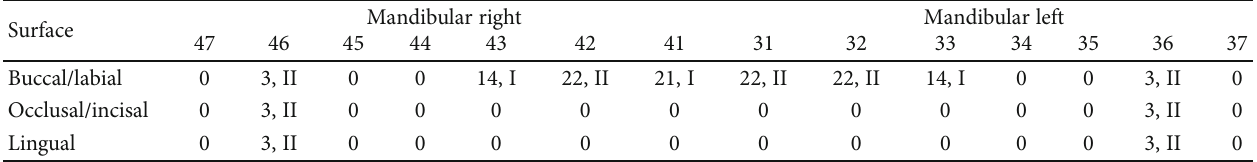
Table 2: Assessment of the clinical status and extent of MIH in mandibular